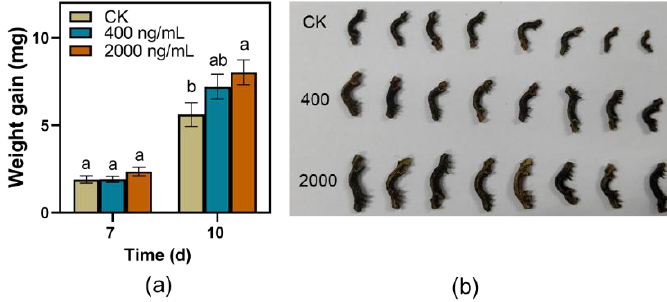
Figure 6. Effect of eriodictyol 7-O-glucuronide (EDG) on the performance of TG. ( a ) Mean larvae weight gain of TG (±SE, n = 25) fed on artificial diet supplemented with EDG in different concentrations; different letters indicate significant differences among treatments ( p < 0.05, Turkey’s test); ( b ) Photos of their performance.